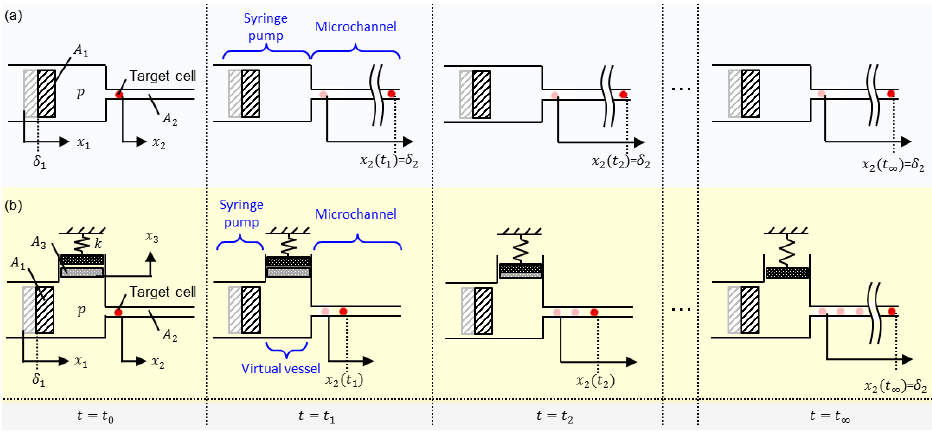
. ( a ) Without elasticity and ( b ) with 1